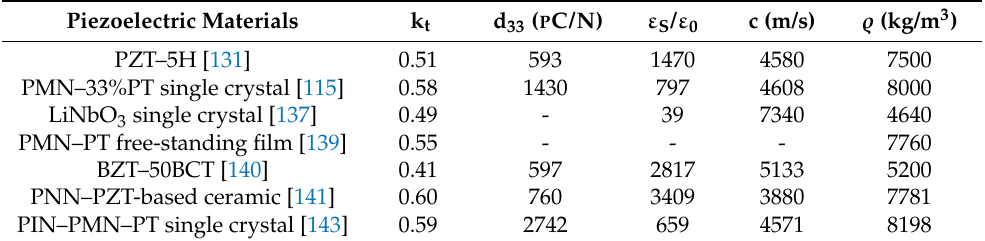
Table 1. Properties of various piezoelectric materials used in intravascular ultrasound (IVUS) transducers. Piezoelectric